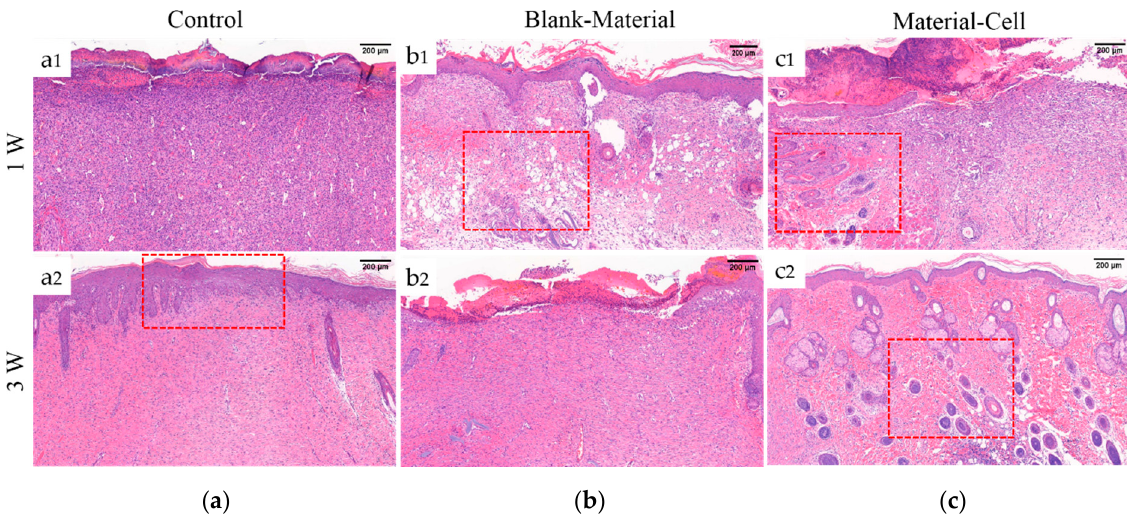
Figure 8. H&E staining of sections of wounds treated by different materials on different days, respectively. ( a ) Control group without any treatment, ( b ) B/M scaffold not inoculated with DPCs, ( c ) M/C scaffold inoculated with DPCs. Scale bar = 200 μ m.